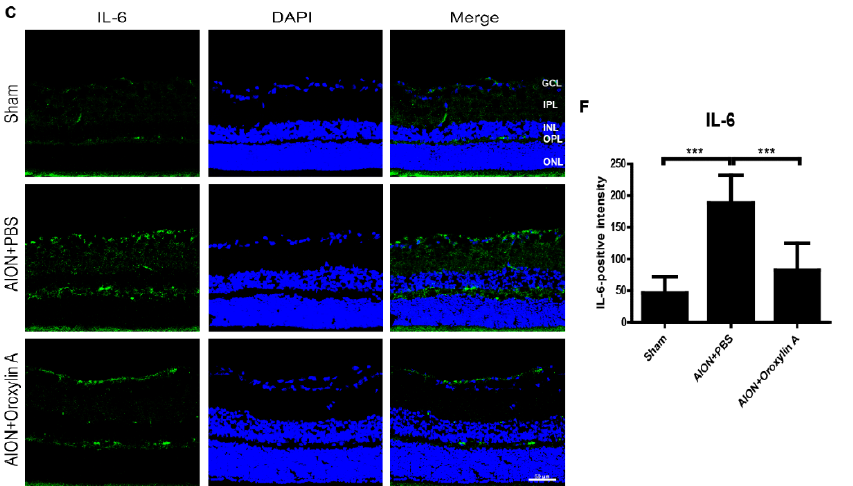
Figure 7. Immunohistochemistry (IHC) of ED1, Iba1, and IL-6 in optic nerves (ONs) 28 days after rAION. ( A ) the lower column indicates the ED1-positive cells (green) per HPF in the sham, PBS-treated, and OA-treated groups. ( D ) the OA-treated group showed significantly fewer ED1-positive cells in the ONs than did the PBS-treated group. The columns indicate that the numbers of ED1-positive cells (green) per HPF in the sham group, PBS-treated group, and OA-treated group were 14.56 ± 5.18, 95.75 ± 15.78, and 62.6 ± 15.39 cells/HPF, respectively. ( B ) immunohistochemistry of Iba1 in the retinas 4 weeks after rAION. ( E ) the columns indicate that the numbers of Iba1-positive cells (green) per HPF in the sham group, PBS-treated group, and OA-treated group were 72.3 ± 34.7, 332.4 ± 90.1, and 103.2 ± 38.3 cells/HPF, respectively. ( C ) immunohistochemistry of IL-6 (green) in the retinas 4 weeks after rAION. ( F ) the columns indicate that the numbers of IL-6-positive cells per HPF in the sham group, PBS-treated group, and OA-treated group were 46.6 ± 26.1, 188.6 ± 43.4, and 82.5 ± 42.5 cells/HPF, respectively. Results represent the means ± SDs. A: Scale bar, 100 µ m (upper), 20 µ m (lower); B and C: Scale bar, 50 µ m; n = 6 in each group. * p < 0.05, *** p ≤ 0.001. GCL: ganglion cell layer; IPL: inner plexiform layer; INL: inner nuclear layer; OPL: outer plexiform